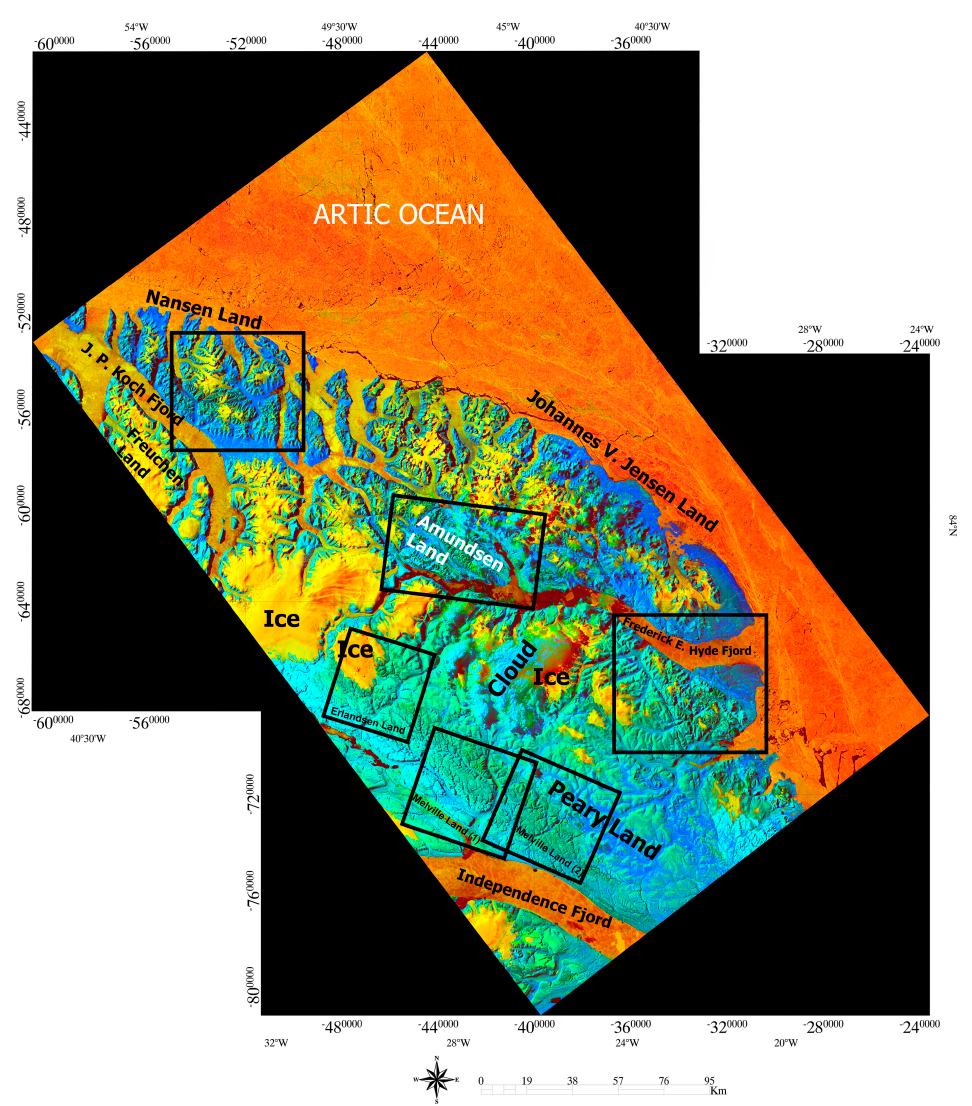
Figure 6. Mosaic of the Landsat-8 (b3 − b6/b3 + b6), (b4/b2) and (b6/b7) ratio images as RGB color composites. It shows a regional view of the eastern part of the Franklinian Basin and selected spatial subsets for detailed mineralogical mapping.